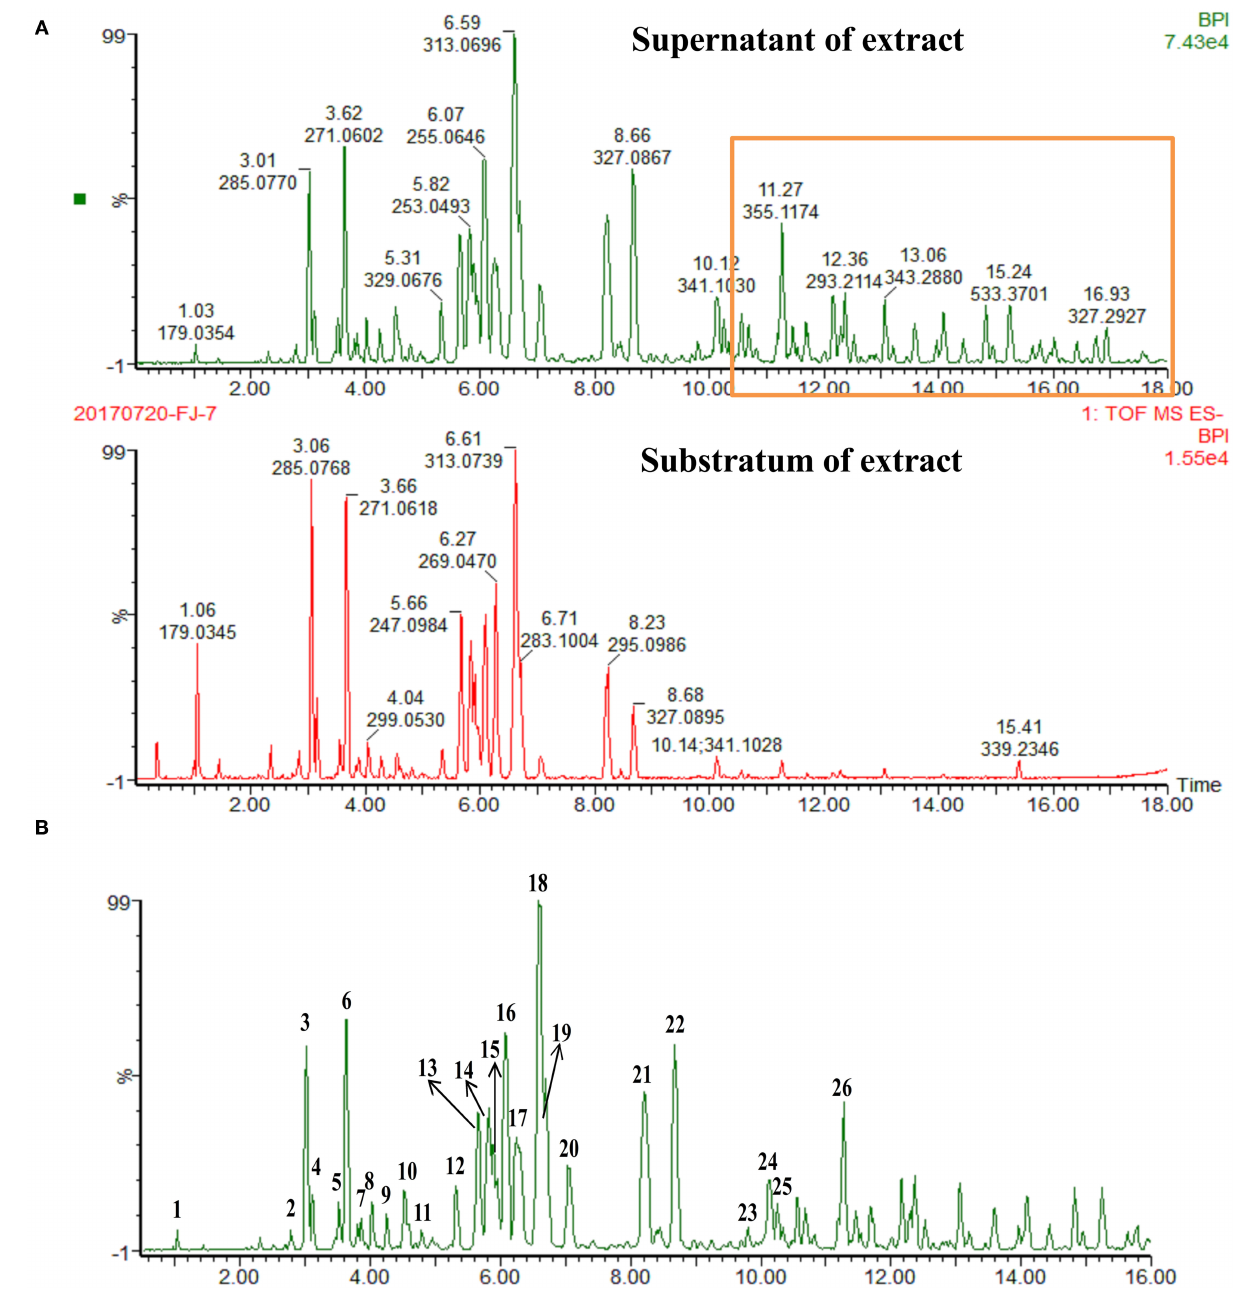
FIGURE 1 | UHPLC-Q/TOF-MS chemical fingerprints (TIC chromatography) of propolis extract. (A) Superstratum and substratum of propolis ethanol extract. (B) (1) Caffeic acid, (2) Quercetin, (3) 5-Methoxypinobanksin, (4) 3-Methoxyquercetin, (5) Apigenin, (6) Pinobanksin, (7) Isorhamnetin, (8) 5-Methoxyluteolin, (9) 5,7-Dimethoxyquercetin, (10) 5-Methoxygalangin, (11) 7-Methoxyquercetin, (12) 7-Methoxyquercetin-X-methyl ester, (13) Isoprene caffeic acid ester, (14) Chrysin, (15) Caffeic acid benzyl ester, (16) Pinocembrin, (17) Galangin, (18) 3-O-Acetylpinobanksin, (19) Caffeic acid phenethyl ester, (20). Methoxychrysin, (21) Cinnamate caffeic acid, (22) Pinobanksin-3-O- propanoate, (23) P-Cinnamyl coumarate, (24) Pinobanksin-3-O-butyrate, (25) Pinobanksin-3-O-pentenoic acid ester, (26)